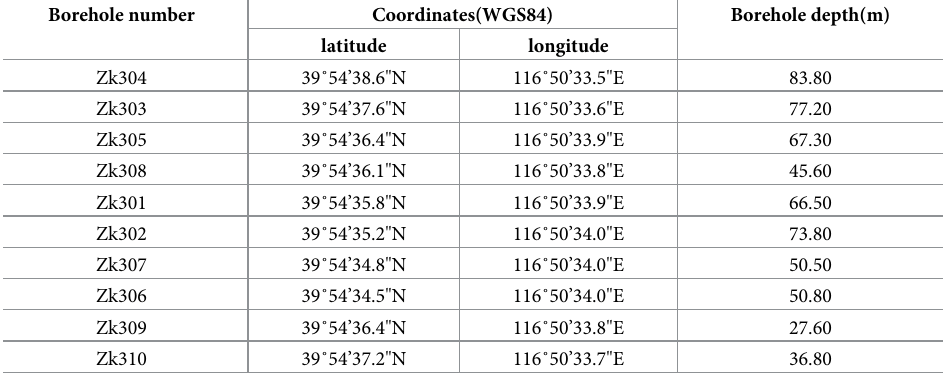
Table 2. Coordinations and depths of the combined row drilling holes at Xiwugezhuang on L3 shallow seismic exploration